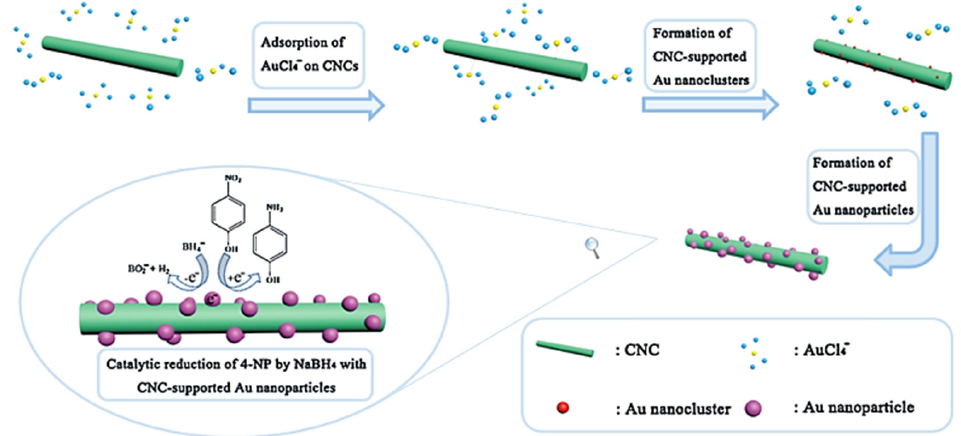
Figure 3. The schematic illustration of the formation process of CNC-supported Au NPs and their catalytic activity in the reduction of nitrophenol. Reprinted from [ 84 ] . Copyright 2015, with permission from Elsevier Ltd.